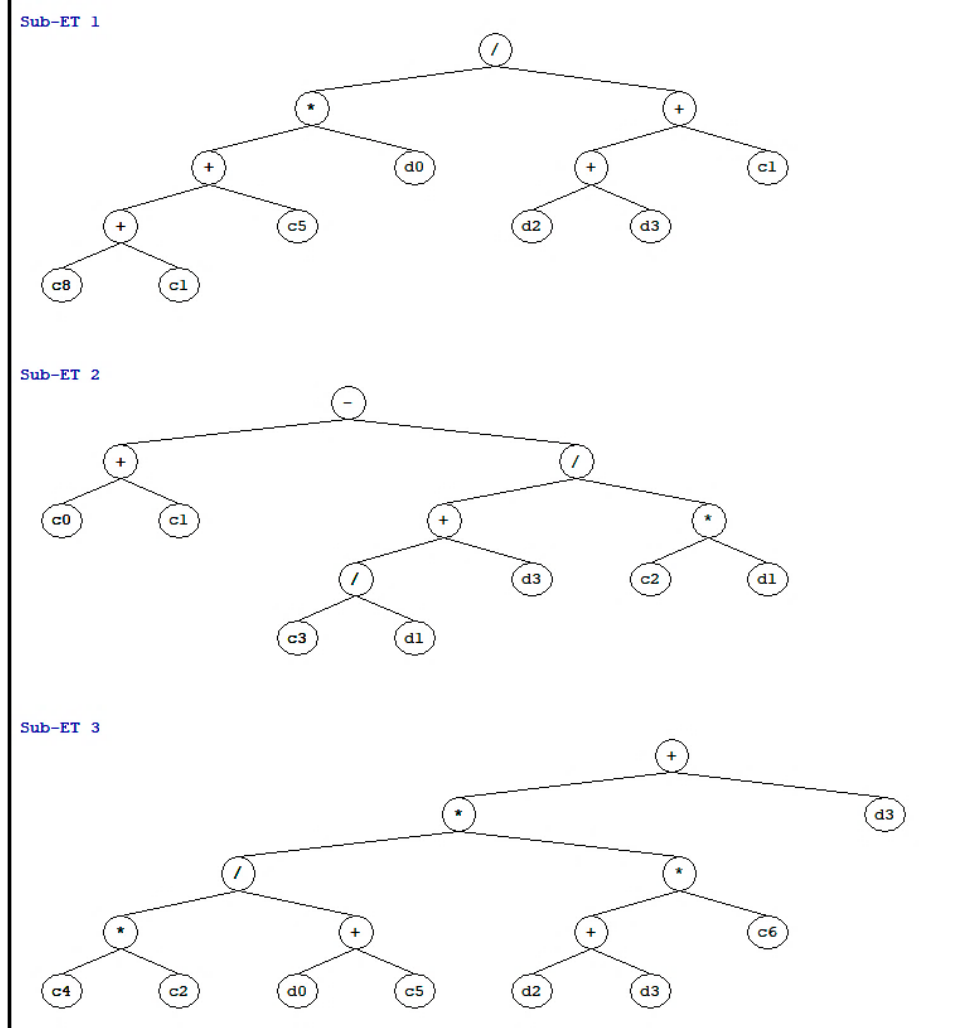
Figure 3. Expression tree of high strength concrete (HSC) using gene expression.